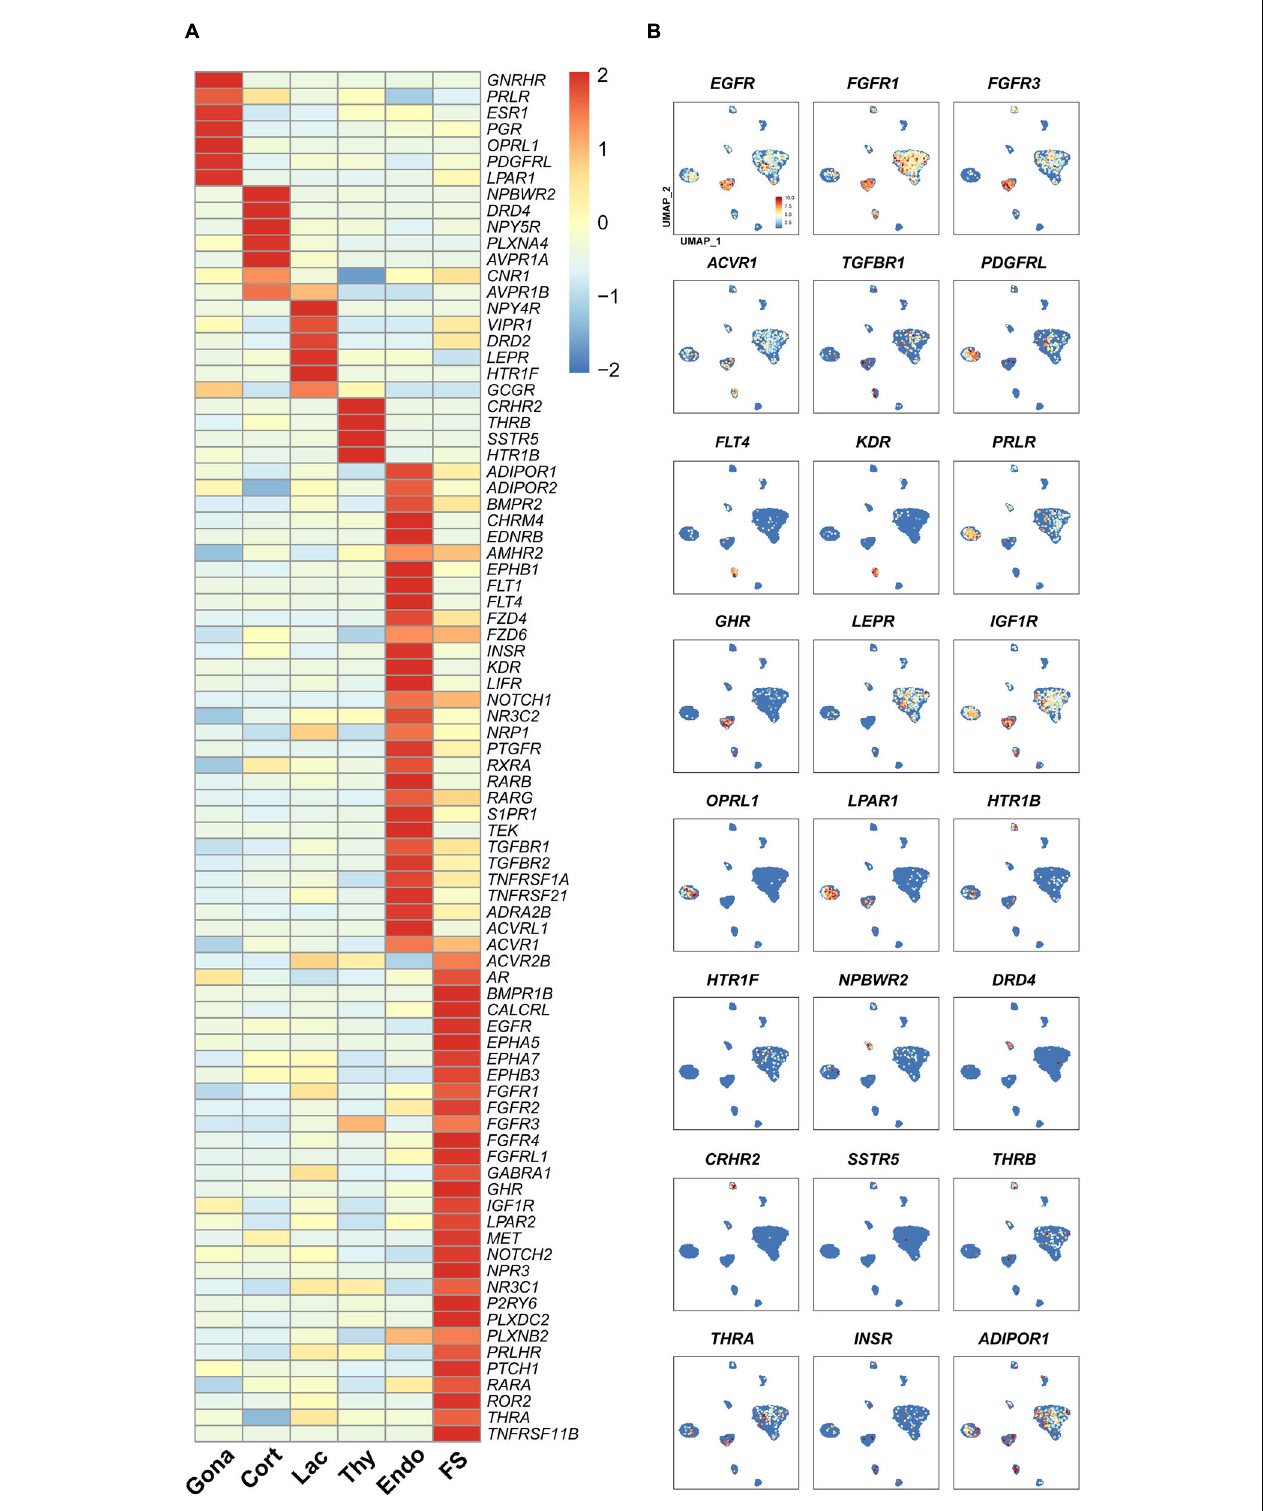
FIGURE 6 | The expression of genes encoding the receptors for endocrine/paracrine/autocrine signals in chicken pituitary cell clusters. (A) Heat-map showing the expression of receptor genes in different pituitary cell types. The expression level of each gene was normalized to the z-score and color-coded. (B) mRNA signals for some receptor genes shown in (A) were projected on the UMAP